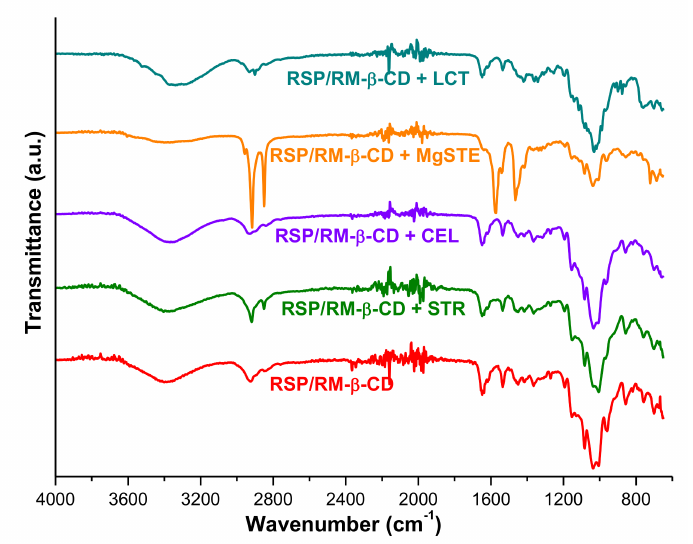
Figure 9. UATR-FTIR spectra of RSP/RM- β -CD inclusion complex and its physical mixtures with selected excipients.